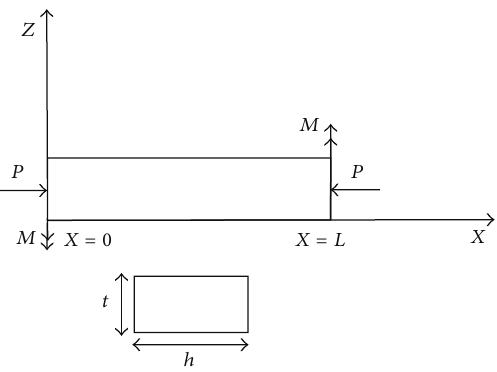
Figure 1: Schematic and coordinate system of the problem, with axial load and end moment applied at 𝑥 = 0 and 𝑥 = 𝐿